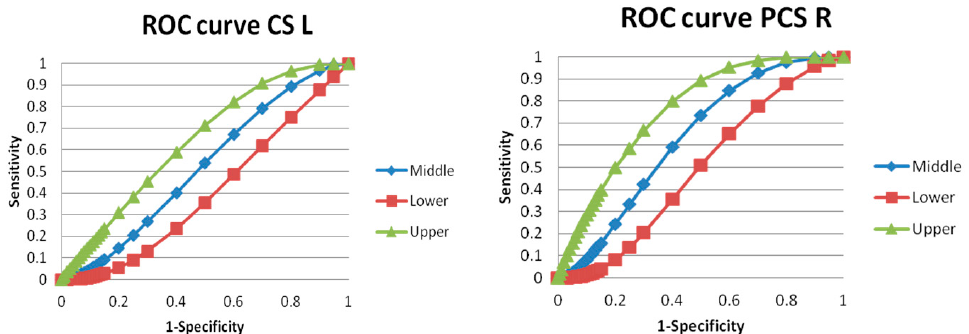
Figure 3. ROC curve analysis for length differences in left cingulate sulcus (CS L) and right paracingulate sulcus (PCS R) in schizophrenia patients vs. controls without morphological parcellation. The area under the fitted curve was 0.52 with SE = 0.056 (CS) and 0.63 with SE = 0.06 (PCS).